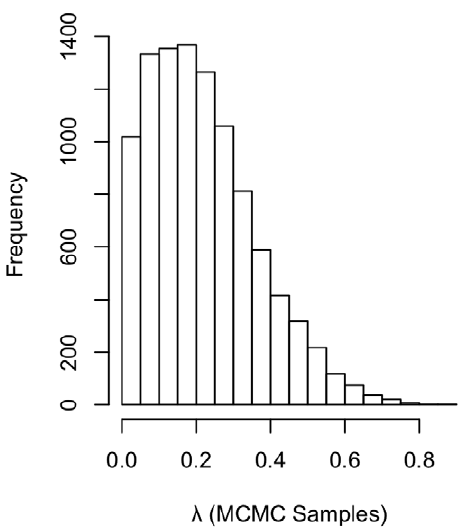
Figure 3. Distribution of l in regression of male number on female number. The distribution of l is wide, but shows a peak at about 0.2. Thus, internal branches are scaled to 1/5 of their original lengths. This result suggests low, but meaningful, phylogenetic signal in the data.